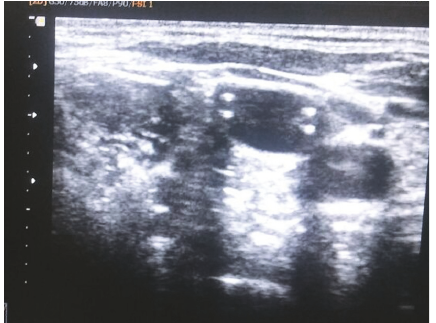
Figure 2: The right internal jugular vein is clearly evident on ultrasonography. Two lumens of the catheter can also be seen.